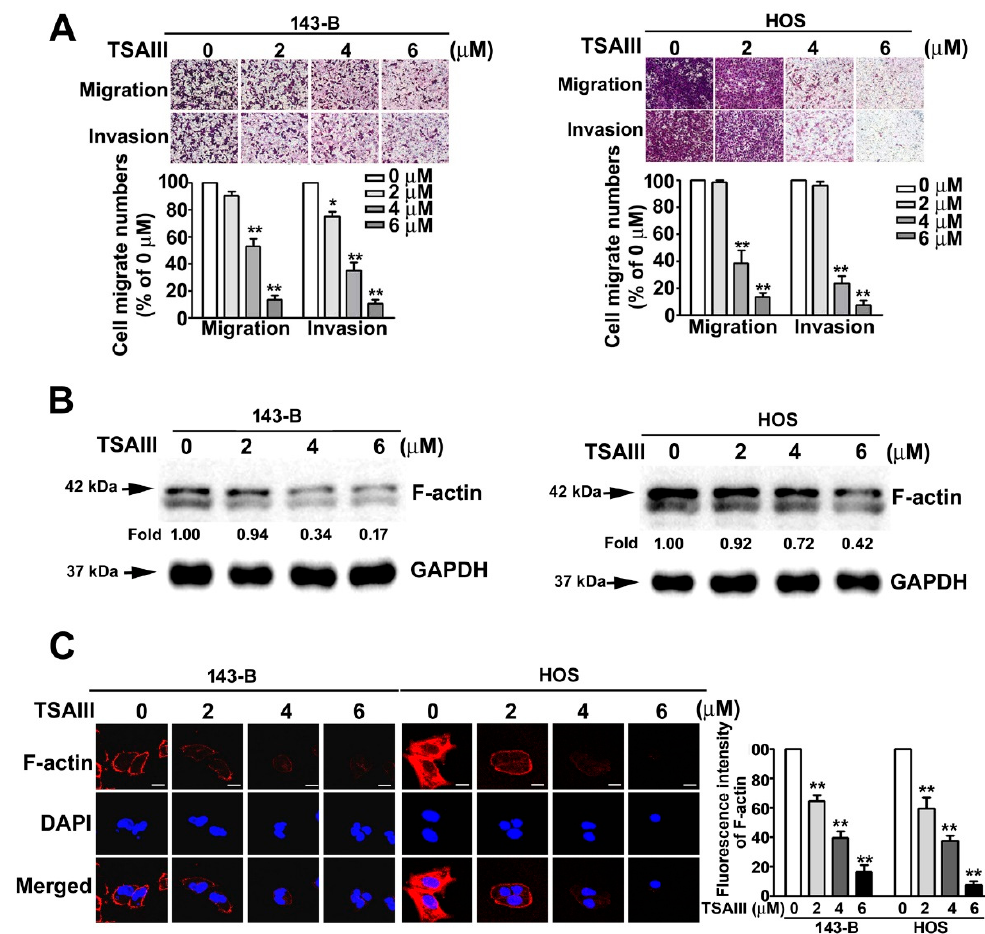
Figure 2. Effect of TSAIII on cell migration, invasion, and F-actin expression of human osteosarcoma cells. ( A ) Human 143-B and HOS osteosarcoma cells were treated with various concentrations of timosaponin AIII (TSAIII; 0, 2, 4, and 6 µ M) for 24 h, and cell migration and invasion abilities were measured. ( B ) Cytoskeletal F-actin expression in human 143-B and HOS osteosarcoma cells exposed to TSAIII (0, 2, 4, 6 µ M) was measured through immunoblotting. Glyceraldehyde-3-phosphate dehydrogenase (GAPDH) was used as the internal control. ( C ) Distribution of cytoskeletal F-actin in 143-B and HOS cells was further confirmed using immunofluorescence analysis. * p < 0.05; ** p < 0.01 versus control. Scale bar: 50 µ m.